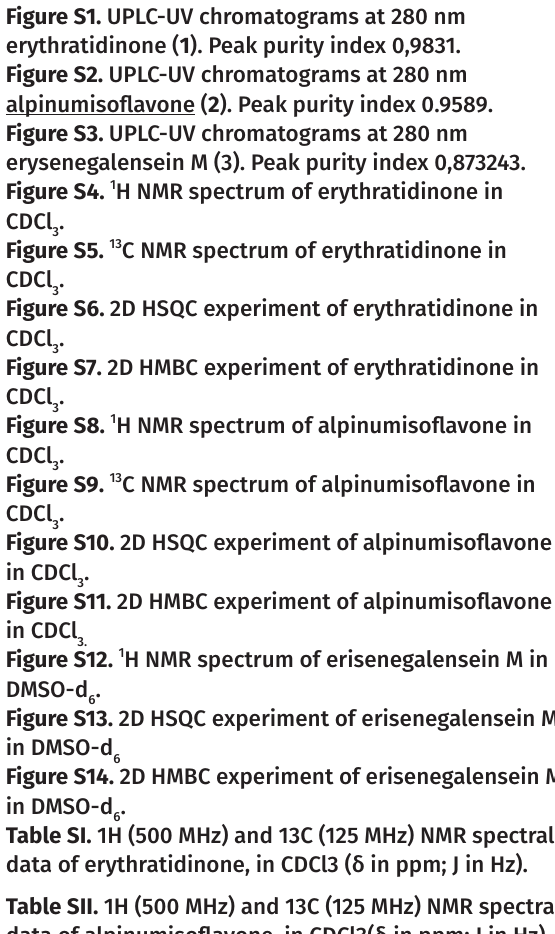
Figure S1. UPLC-UV chromatograms at 280 nm erythratidinone ( 1 ). Peak purity index 0,9831. Figure S2. UPLC-UV chromatograms at 280 nm alpinumisoflavone ( 2 ). Peak purity index 0.9589. Figure S3. UPLC-UV chromatograms at 280 nm erysenegalensein M (3). Peak purity index 0,873243. Figure S4. 1 H NMR spectrum of erythratidinone in . CDCl 3 Figure S5. 13 C NMR spectrum of erythratidinone in . CDCl 3 Figure S6. 2D HSQC experiment of erythratidinone in CDCl . 3 Figure S7. 2D HMBC experiment of erythratidinone in . CDCl 3 Figure S8. 1 H NMR spectrum of alpinumisoflavone in CDCl . 3 Figure S9. 13 C NMR spectrum of alpinumisoflavone in CDCl . 3 Figure S10. 2D HSQC experiment of alpinumisoflavone in CDCl . 3 Figure S11. 2D HMBC experiment of alpinumisoflavone in CDCl 3. Figure S12. 1 H NMR spectrum of erisenegalensein M in DMSO-d . 6 Figure S13. 2D HSQC experiment of erisenegalensein M in DMSO-d 6 Figure S14. 2D HMBC experiment of erisenegalensein M in DMSO-d . 6 Table SI. 1H (500 MHz) and 13C (125 MHz) NMR spectral data of erythratidinone, in CDCl3 (δ in ppm; J in Hz). Table SII. 1H (500 MHz) and 13C (125 MHz) NMR spectral data of alpinumisoflavone, in CDCl3(δ in ppm; J in Hz). Table SIII. 1 H (500 MHz) and 13 C (125 MHz) NMR spectral data of erisenegalensein M, in DMSO-d